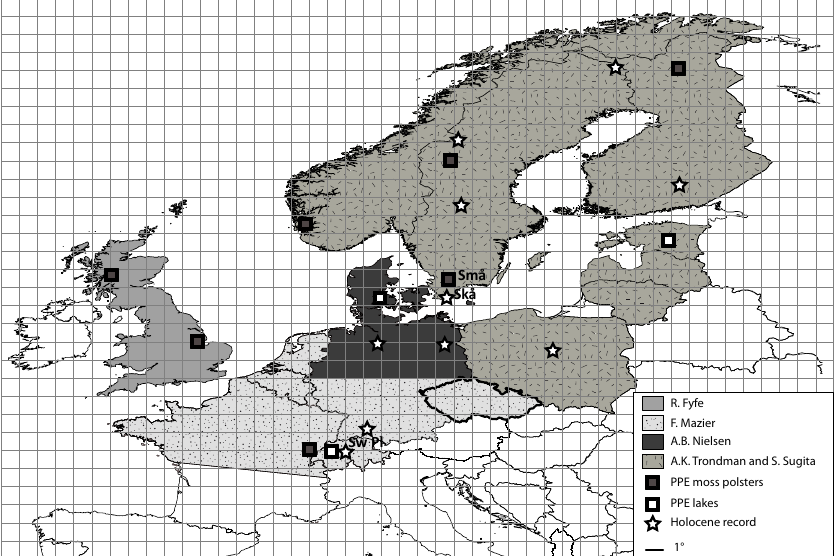
Fig. 8. Study area of the LANDCLIM project. It is devided between four principal investigators. The regions where pollen productivities were estimated from modern pollen data (in moss polsters or surface lake sediments) and related vegetation data are indicated. REVEALS reconstructions performed within the LANDCLIM project are presented in Figs. 10 and 11 for the Czech Republic (emphasized by a thick land boarder). REVEALS reconstructions of vegetation changes over the entire Holocene will be performed for 10 target sites (indicated by stars on the map); such reconstructions are presented in Fig. 7 for the provinces of Sk˚ane (Sk˚a) and Sm˚aland (Sm˚a).